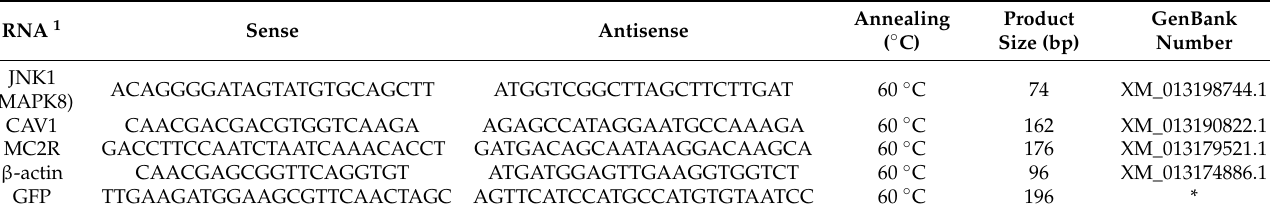
Table 1. Primer information for